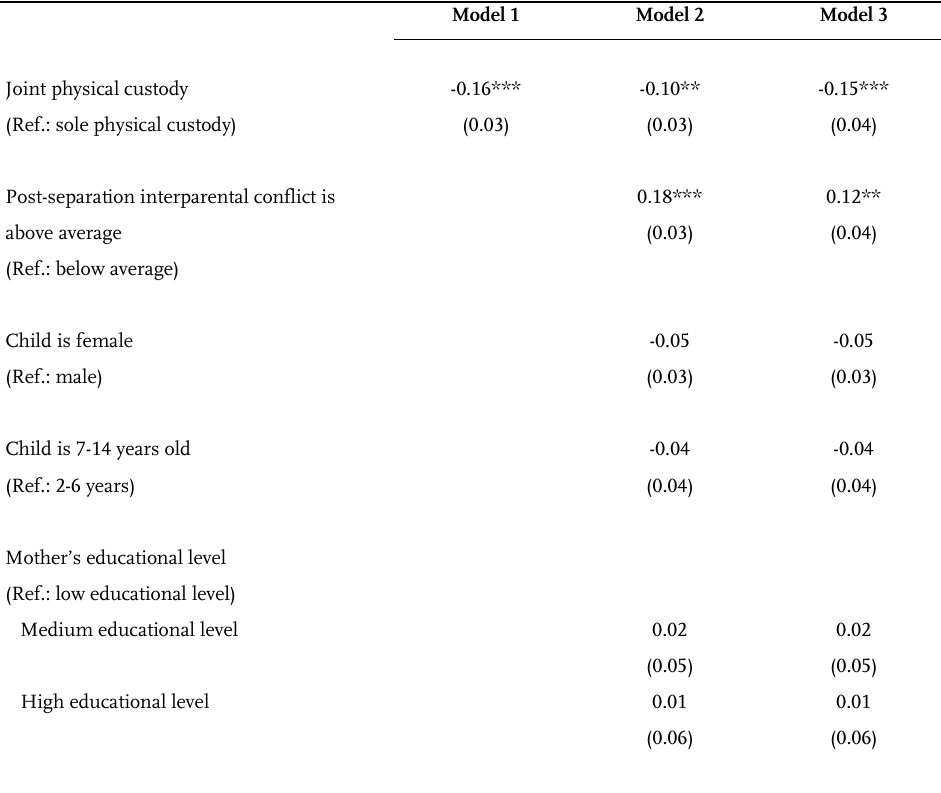
Table 2 : Linear regression models: The determinants of children’s mental health problems in post-separation families (standardized